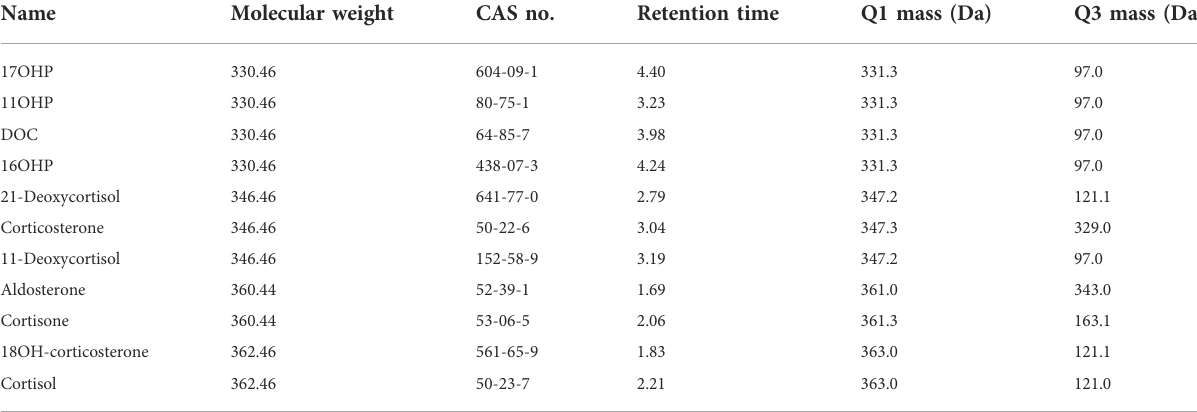
TABLE 5 Steroid hormones used for speci fi city analysis, including the molecular mass and the concentration used during testing.